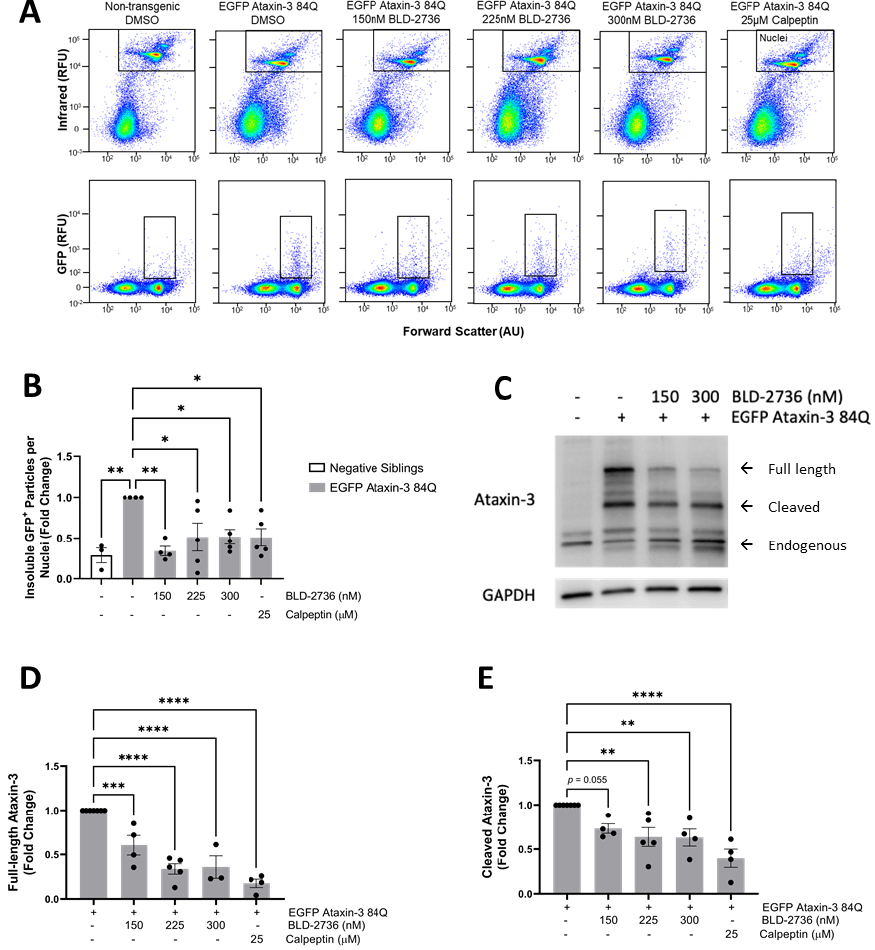
Figure 2. Treatment with BLD-2736 from 1 to 6 days post-fertilization reduces the presence of ataxin-3 protein species. ( A ) Representative scatterplots showing flow cytometric detection of detergent- insoluble EGFP-fused ataxin-3 particles following calpain inhibitor treatments. ( B ) The number of detergent-insoluble EGFP particles relative to nuclei was decreased following treatment with calpain inhibitors. ( C ) Representative western blot showing the presence of full length and cleaved ataxin-3 protein species. ( D ) Calpain inhibitor treatments were found to decrease the presence of full length ataxin-3 species in a dose-dependent manner. ( E ) Calpain inhibitor treatments also produced a decrease in the presence of cleaved ataxin-3 species, as detected by Western blotting. All data are presented as mean ± SEM. Each data point represents a single experimental replicate, where samples were pooled from n = 12–20 zebrafish larvae. * represents p < 0.05, ** represents p < 0.01, *** represents p < 0.001, **** represents p < 0.0001.